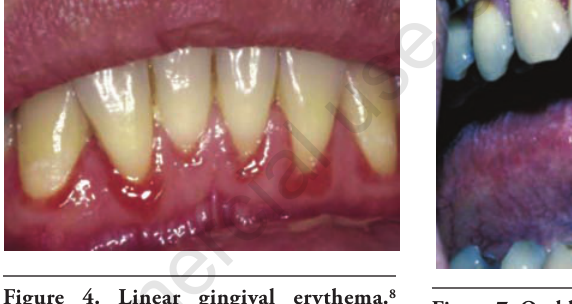
Figure 7. Oral hairy leukoplakia. 31